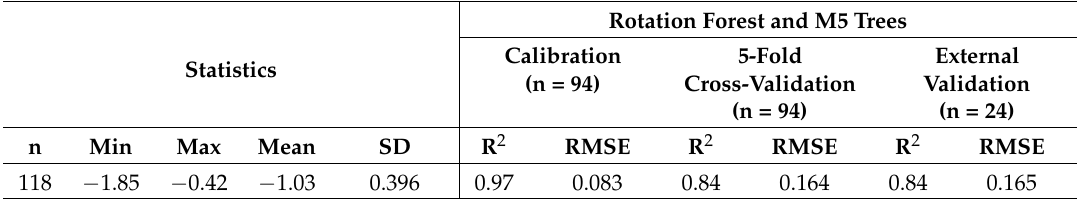
Table 6. Statistic overview and results of the ψ stem (MPa) estimation using a rotation forest and M5